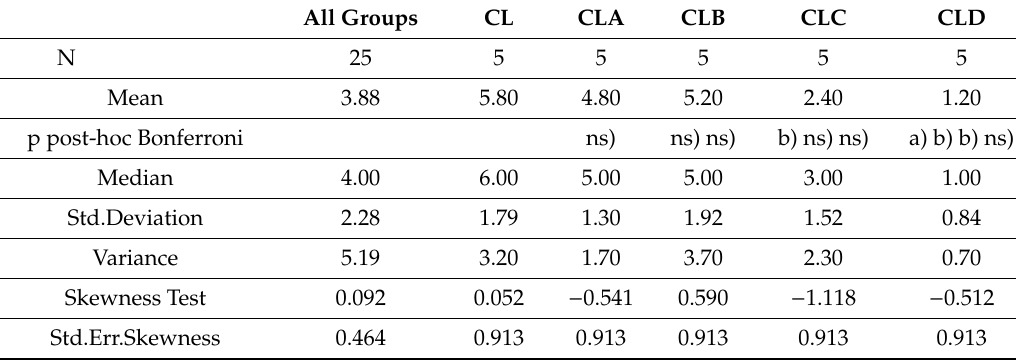
Table 2. Statistical indicators of the number of blood vessels / field compared to study groups. All